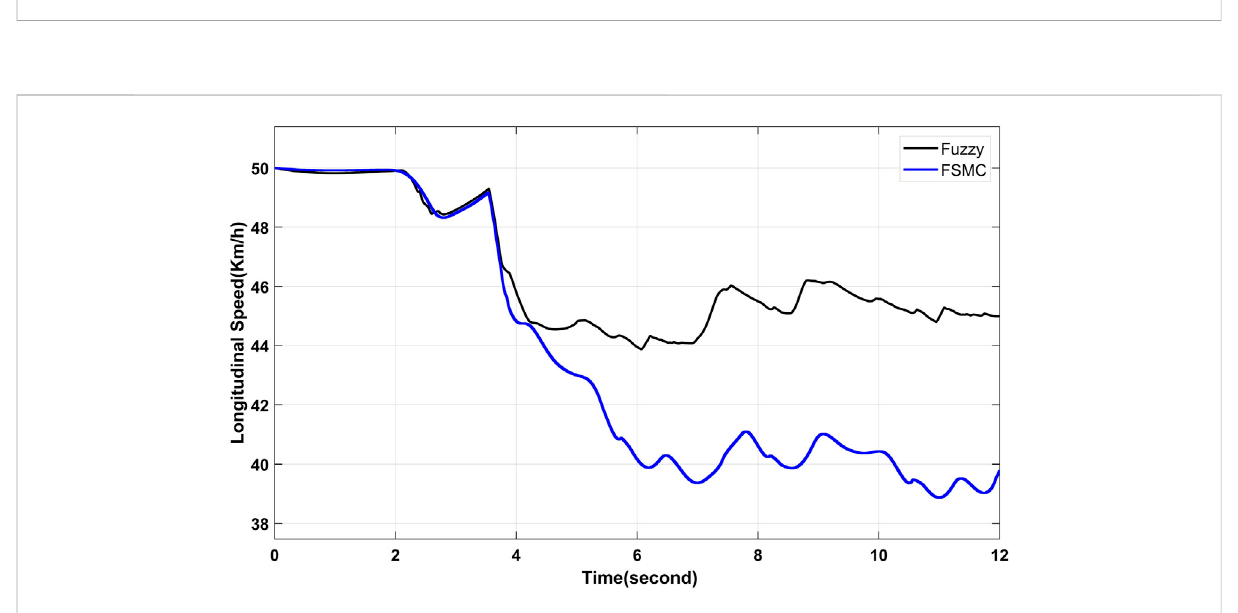
FIGURE 13 Longitudinal speed controller simulation